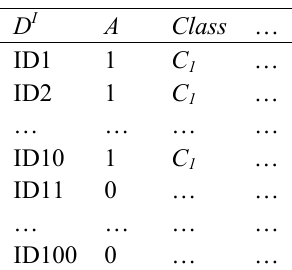
Table 7: Database D I